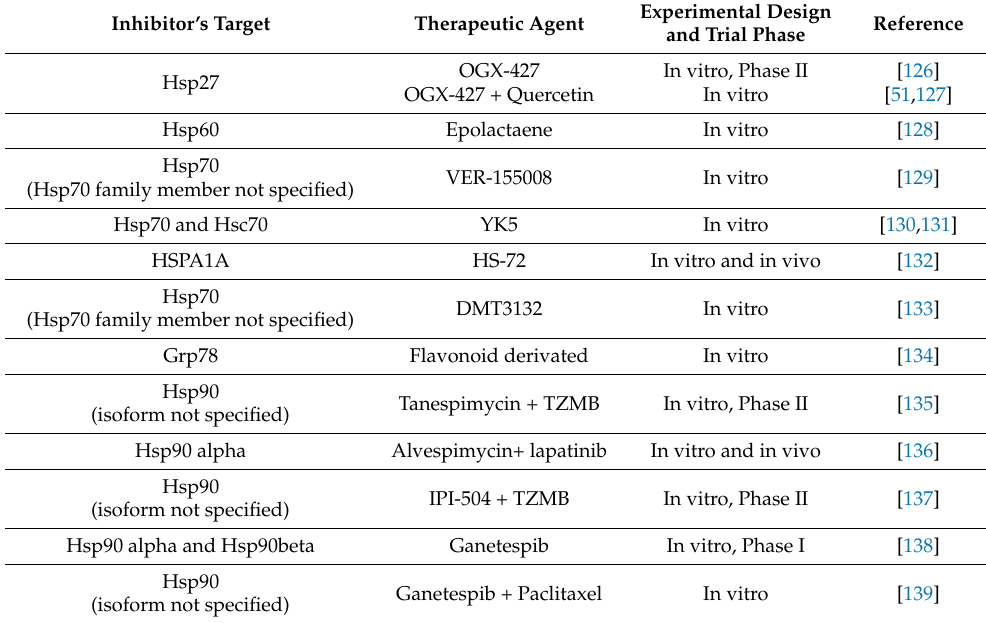
Table 1. Hsp inhibitors used alone or in combination with other therapeutic